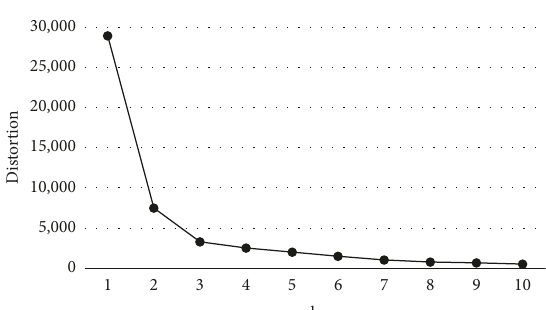
Figure 7: Distortion based on different ( k ) values for the 2018